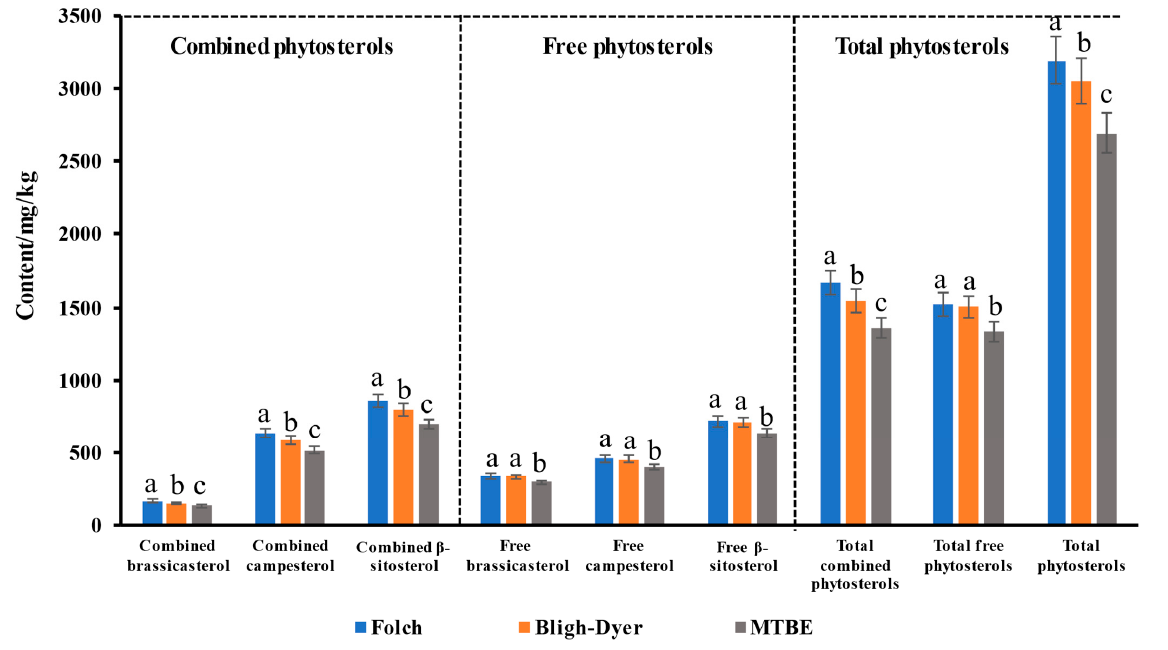
Figure 4. Optimization of the liquid–liquid extraction method. Values are the means ± standard deviations; n = 3 parallel determinations. a–c Mean values (a > b > c, corresponding to the same parameter) not followed by a common letter differ significantly ( p < 0.05).